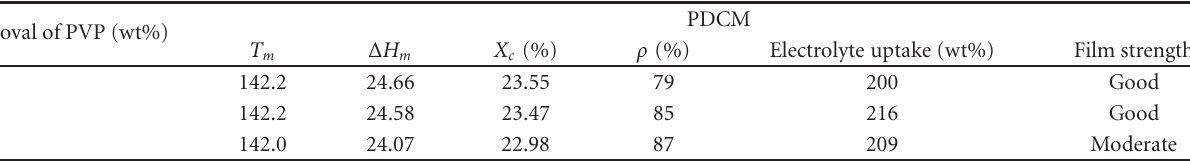
Table 3: Thermal and other physical properties of composite microporous membranes obtained by preferential polymer dissolutionmethod (PDCMs).